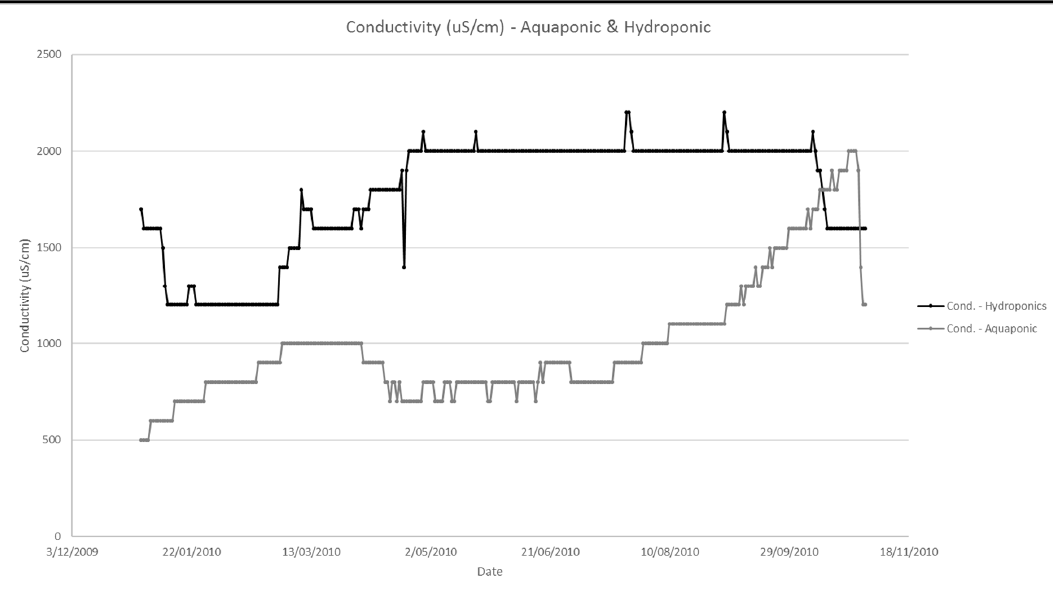
Figure 4. Daily conductivity readings Aquaponic and Hydroponic systems.